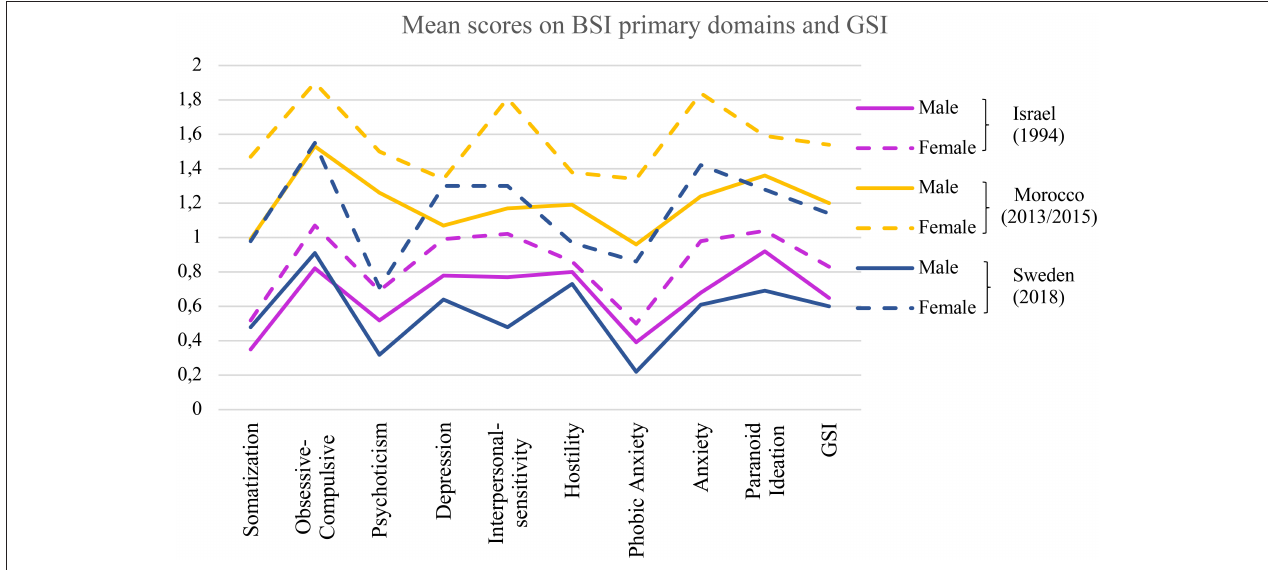
FIGURE 4 | Psychological distress captured by BSI in the male and female adolescent populations of three countries’